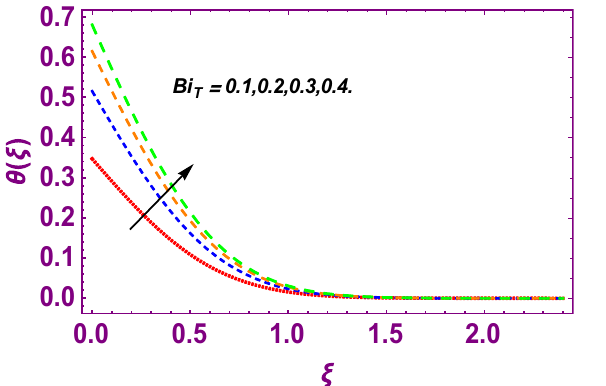
Figure 10. Influence of thermal Biot number upon θ(ξ) .